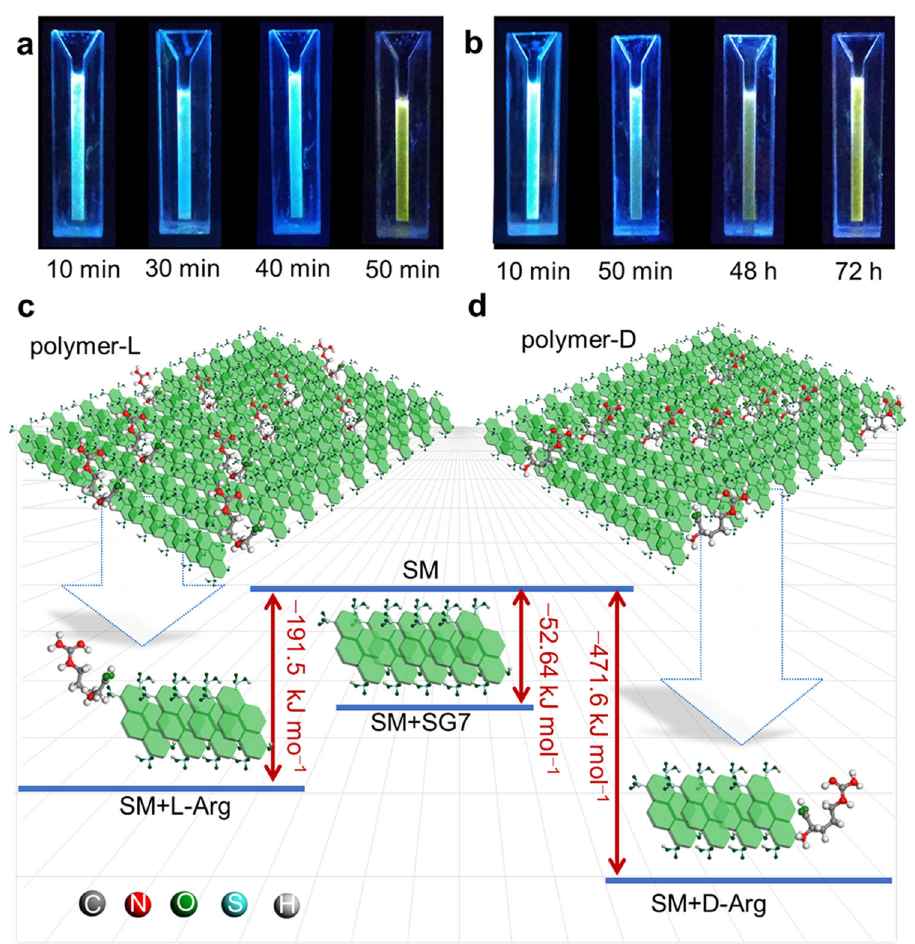
Fig. 5 Application in the chiral recognition. Photos under UV light of chiral recognition products of metastable LSM 3000 to a L -Arg and b D -Arg during co- assembly process, noted that only ultrasound for 50 min. c − d Optimized geometries of metastable LSM 3000 to c L -Arg and d D